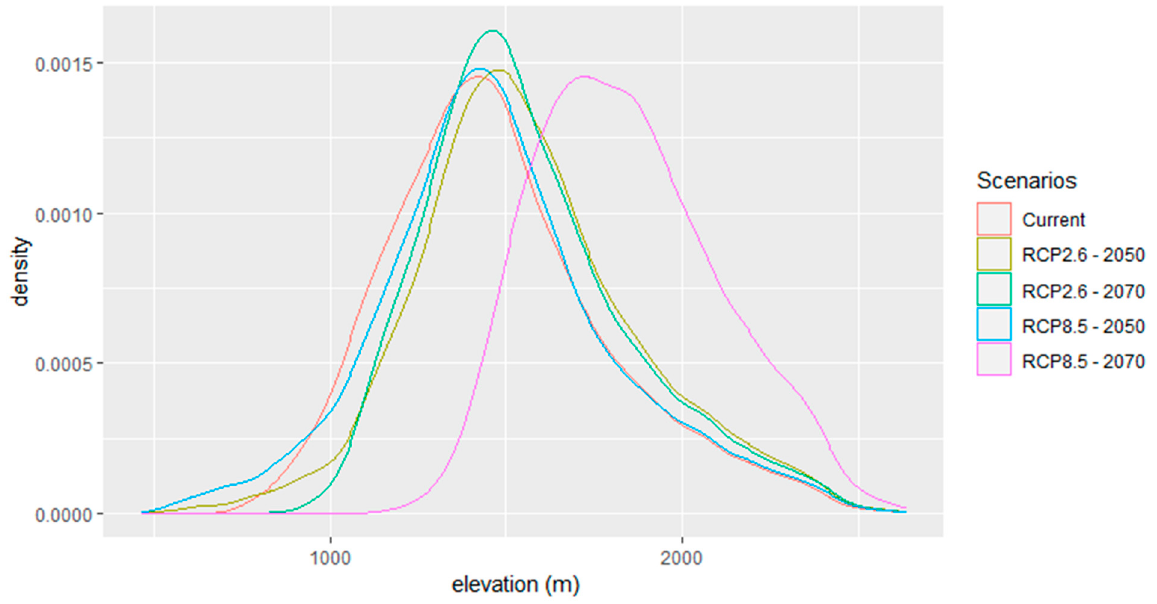
Figure 8. The relationship between elevation and the distribution of Persian oak under current and future climatic conditions.